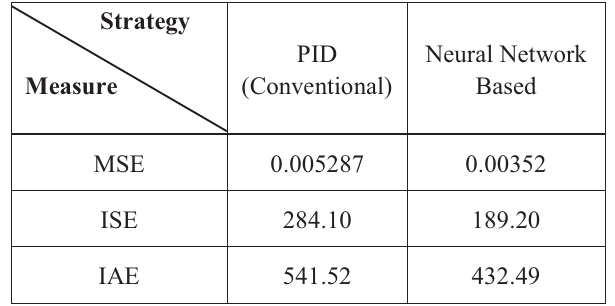
Table 2: Numerical comparison of PID (Conventional) and neural network based control performance